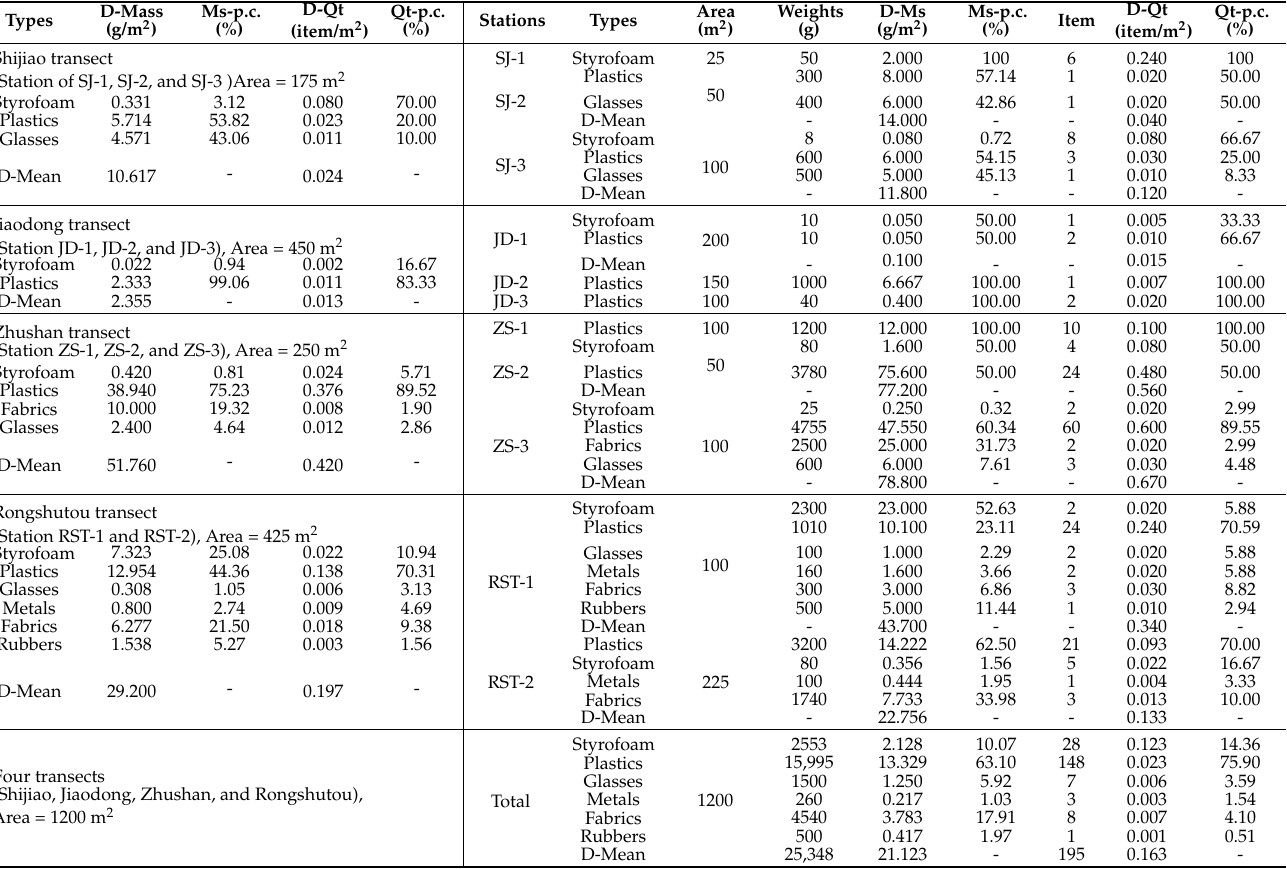
Table 3. Mass weights and quantities of debris in Shijiao, Jiaodong, Zhushan and Rongshutou transects in Beilun Estuary mangrove forest.